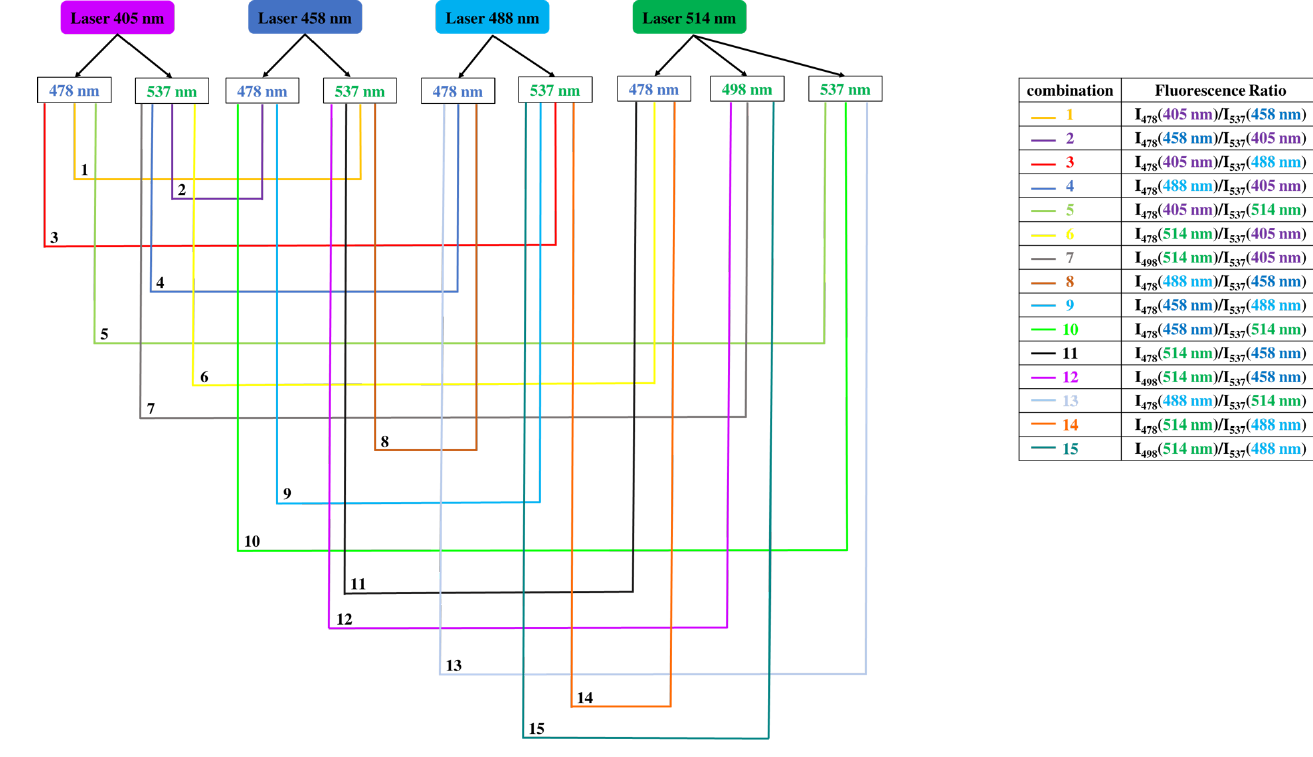
Figure 7. The 15 combinations made between one minor and one major emission wavelength of two different spectra of BCECF. For each combination, the ratio of fluorescence intensities measured at the two emission wavelengths is monitored as a function of